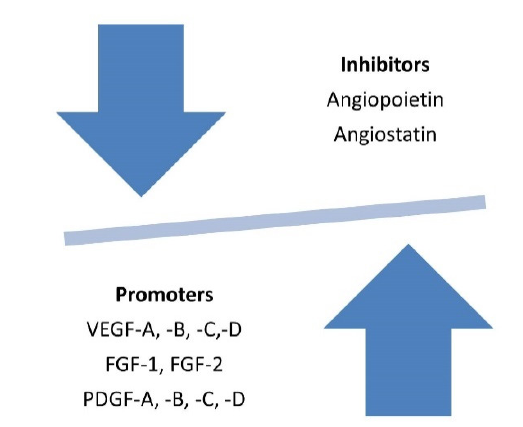
Figure 6. A balance of promoters (proangiogenic factors) and inhibitors (anti-angiogenic factors) of angiogenesis in an athlete’s body (brain, myocardium, lung, and skeletal muscle). angiogenesis in an athlete’s body (brain, myocardium, lung, and skeletal